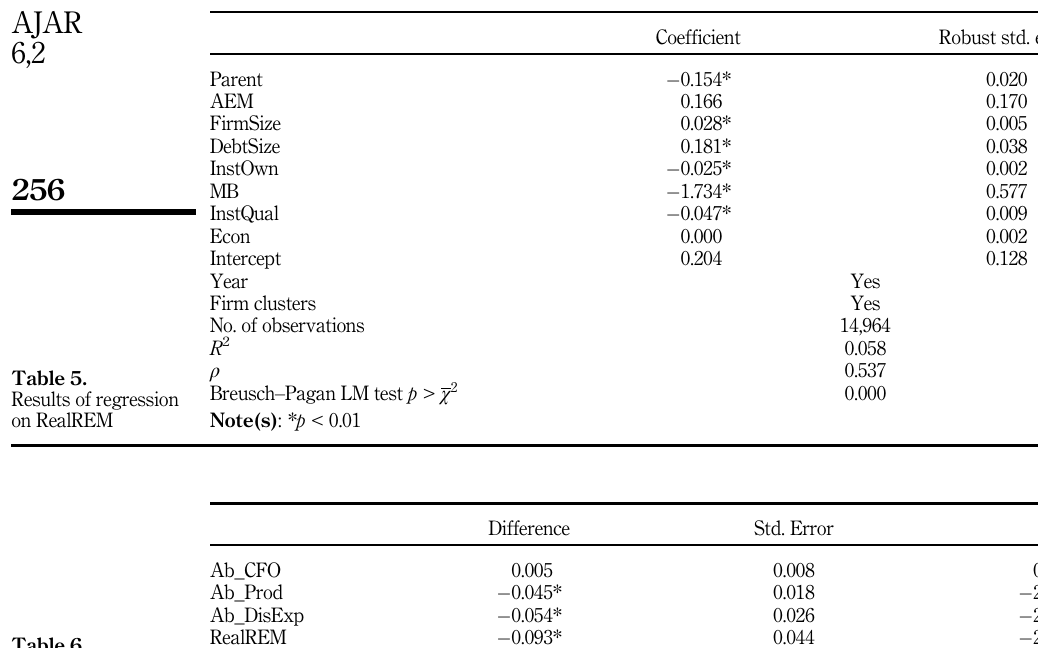
Table 6. Results of propensity score